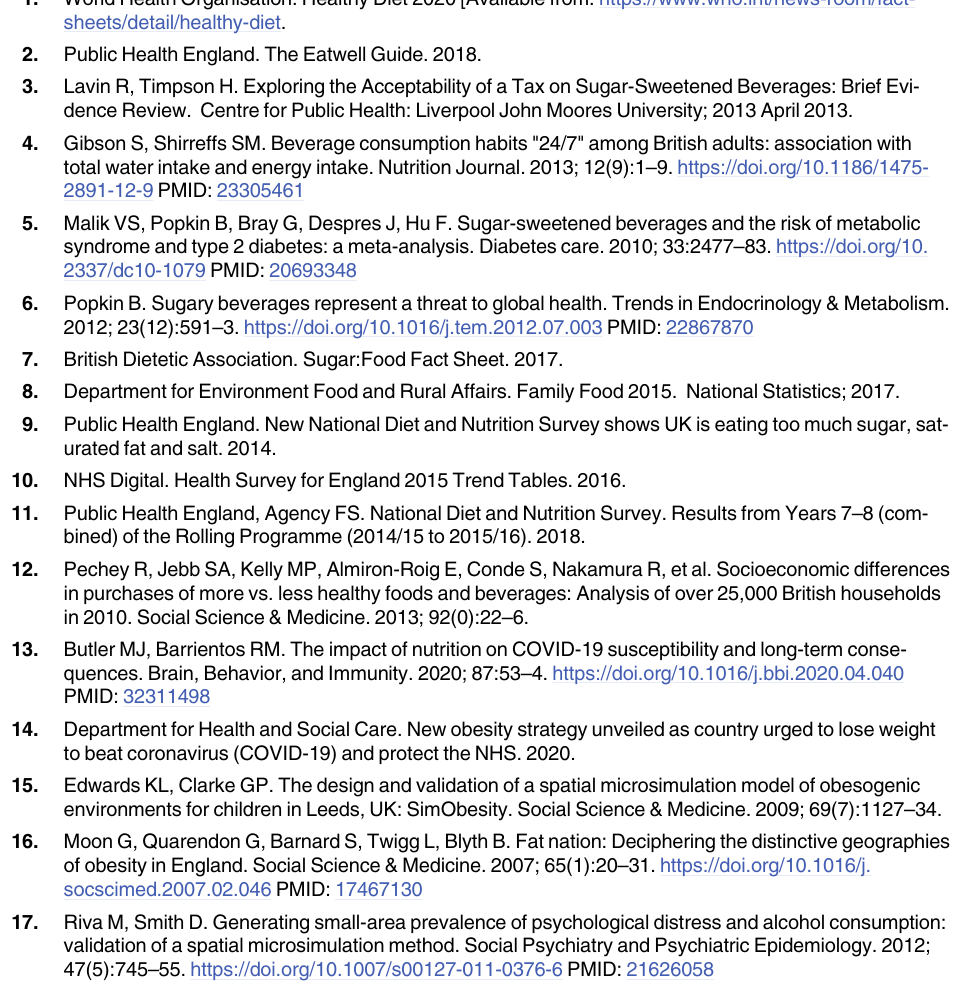
S1 Table. Point estimates of diet behaviours in MSOAs. Prevalence of diet behaviours in adults using 2018 population